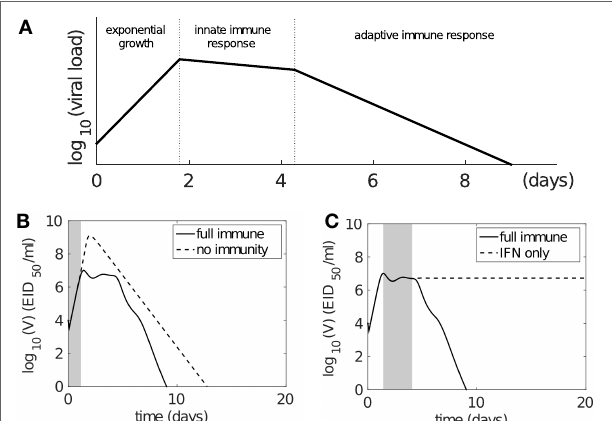
FIGURE 4 | The model solution exhibits three-phase behavior following influenza virus infection . (A) Schematic representation of three phases of behavior based on involvement of immune responses. Following infection, virus first undergoes rapid exponential growth before the innate immune response is activated (on day 2). Innate immunity controls rapid viral expansion to form a plateau in viral load. Adaptive immunity starts to take effect 4–6days postinfection and is responsible for viral clearance. (B,C) demonstrate that the model dynamics follow the three-phase theory. Viral kinetics in the presence of a full immune response is shown by the solid line (B,C) . (B) The dashed line shows viral kinetics in the complete absence of immunity (innate and adaptive; by letting p F = 0 and β Cn = β Bn = 0 in the model). The trajectories overlap prior to the activation of the innate response, before diverging due to target cell depletion. The shaded region highlights the first phase (exponential growth). (C) The dashed line shows viral kinetics in the absence of adaptive immunity (by letting β Cn = β Bn = 0; innate immunity remains active). The trajectories overlap prior to the activation of the adaptive response. The shaded region highlights the second phase (innate response). Note: changes in model parameters shifts where the three phases occur, but does not alter the underlying three-phase structure, i.e., existence of the three phases is robust to variation in parameters (see Supplementary Material and Figure S3 in Supplementary Material in